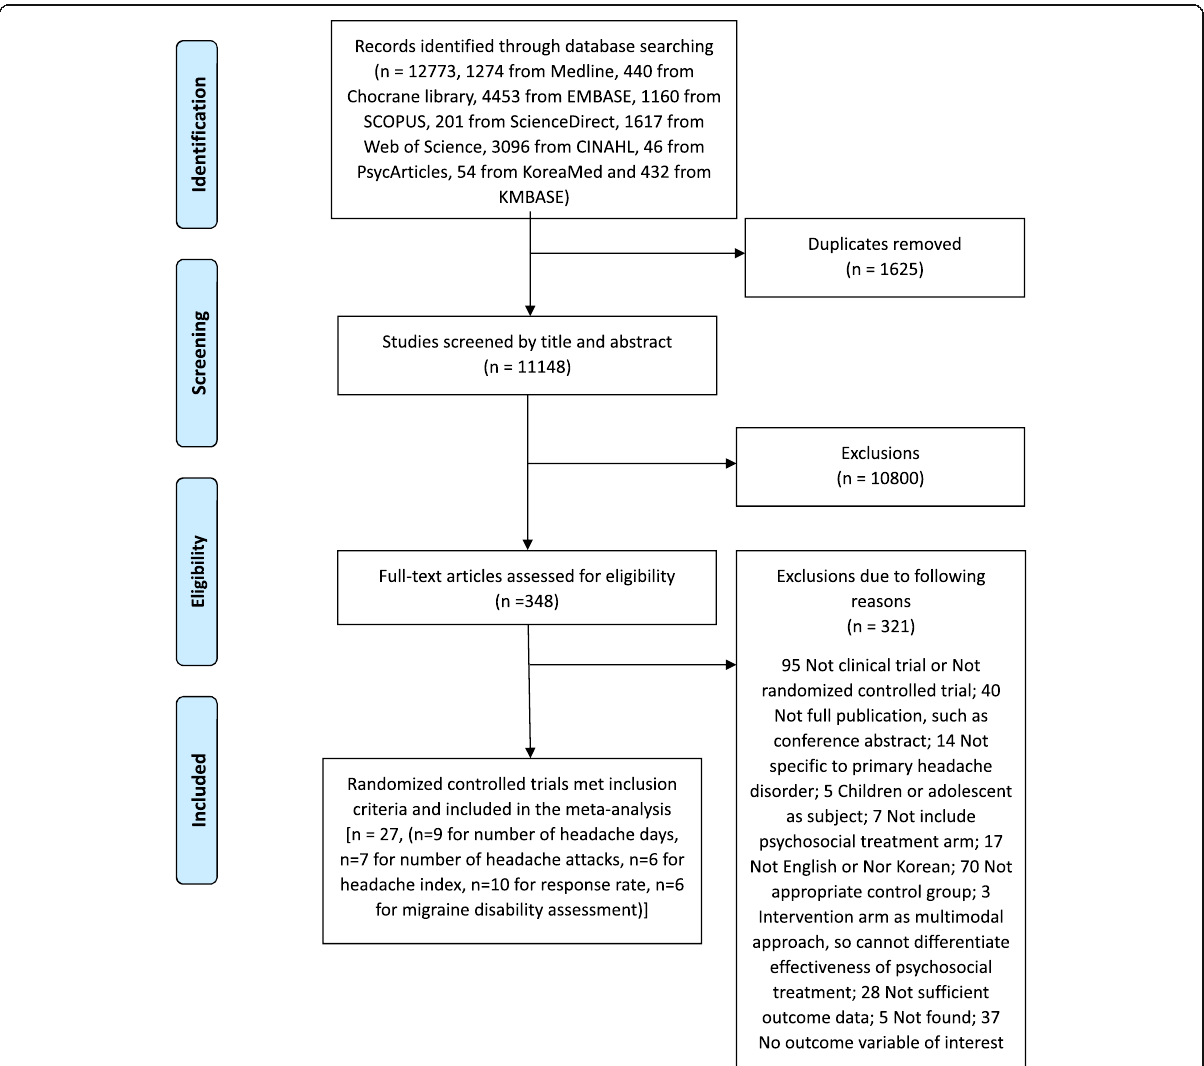
Fig. 1 Schematic presentation of studies selected in the present